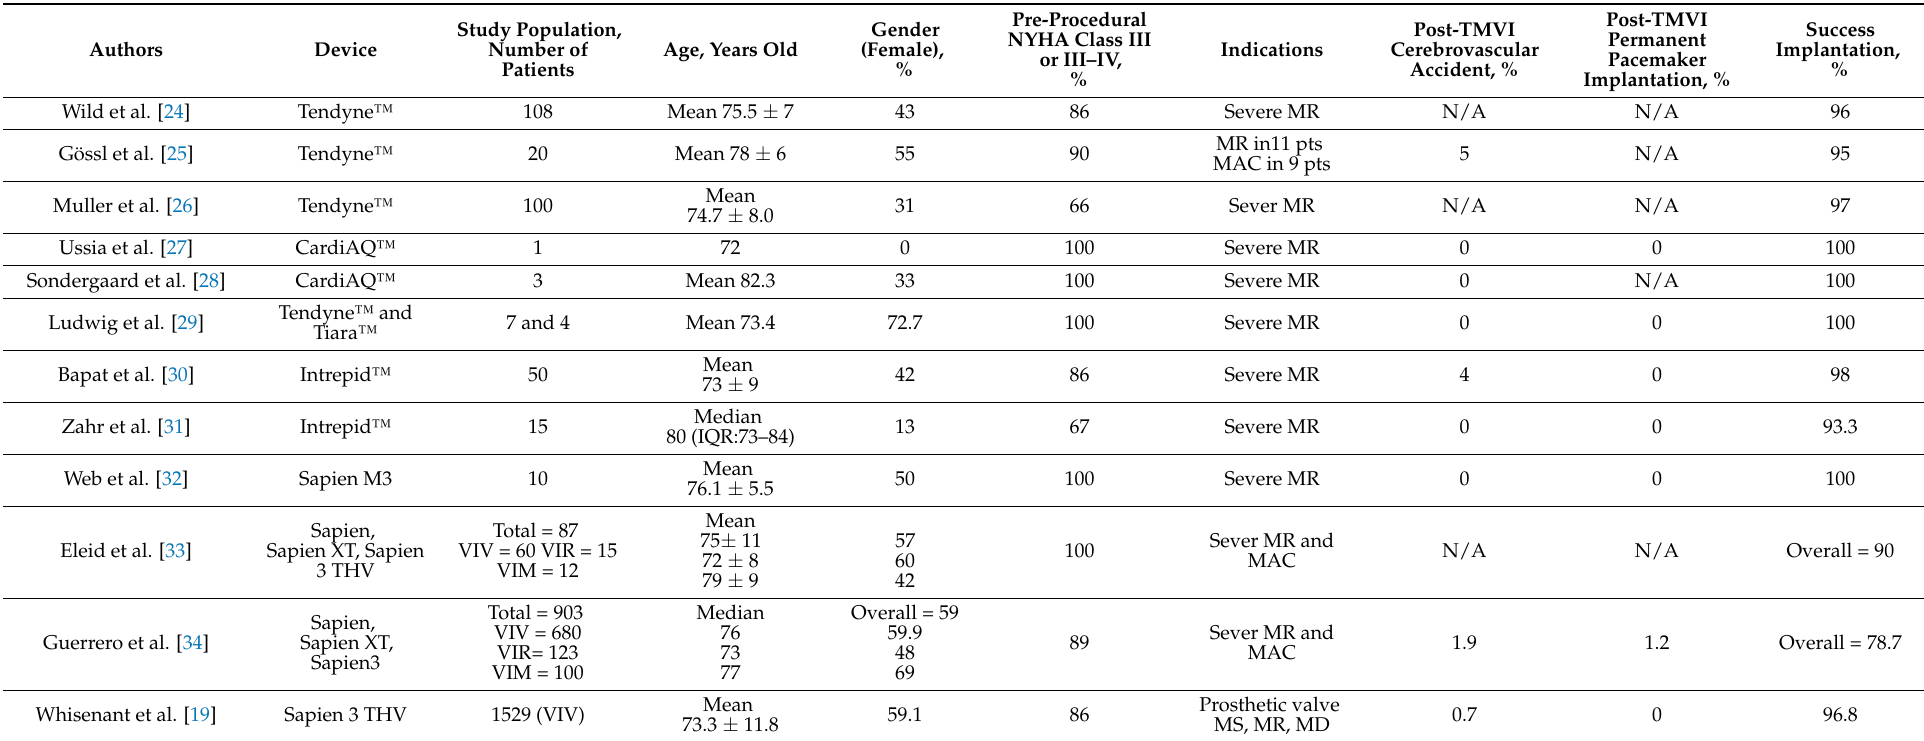
Table 1. Baseline characteristics of patients, indications for TMVI and the most common post-procedural complications after TVMI. VIV = valve-in-valve; VIR = valve-in-ring; VIM = valve-in-mitral valve calcification; N/A = not applicable; MAC = mitral annular calcification; MR = mitral valve regurgitation; MS = mitral stenosis; MD = mixed disease; NYHA class = New York Heart Association Classification; IQR = interquartile